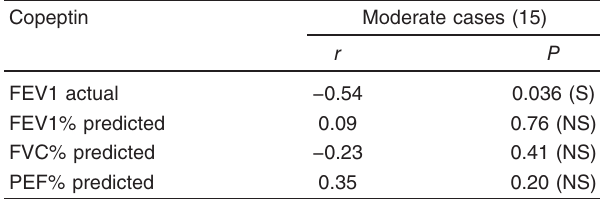
Table 7 Correlation between copeptin and pulmonary function tests in moderate disease group